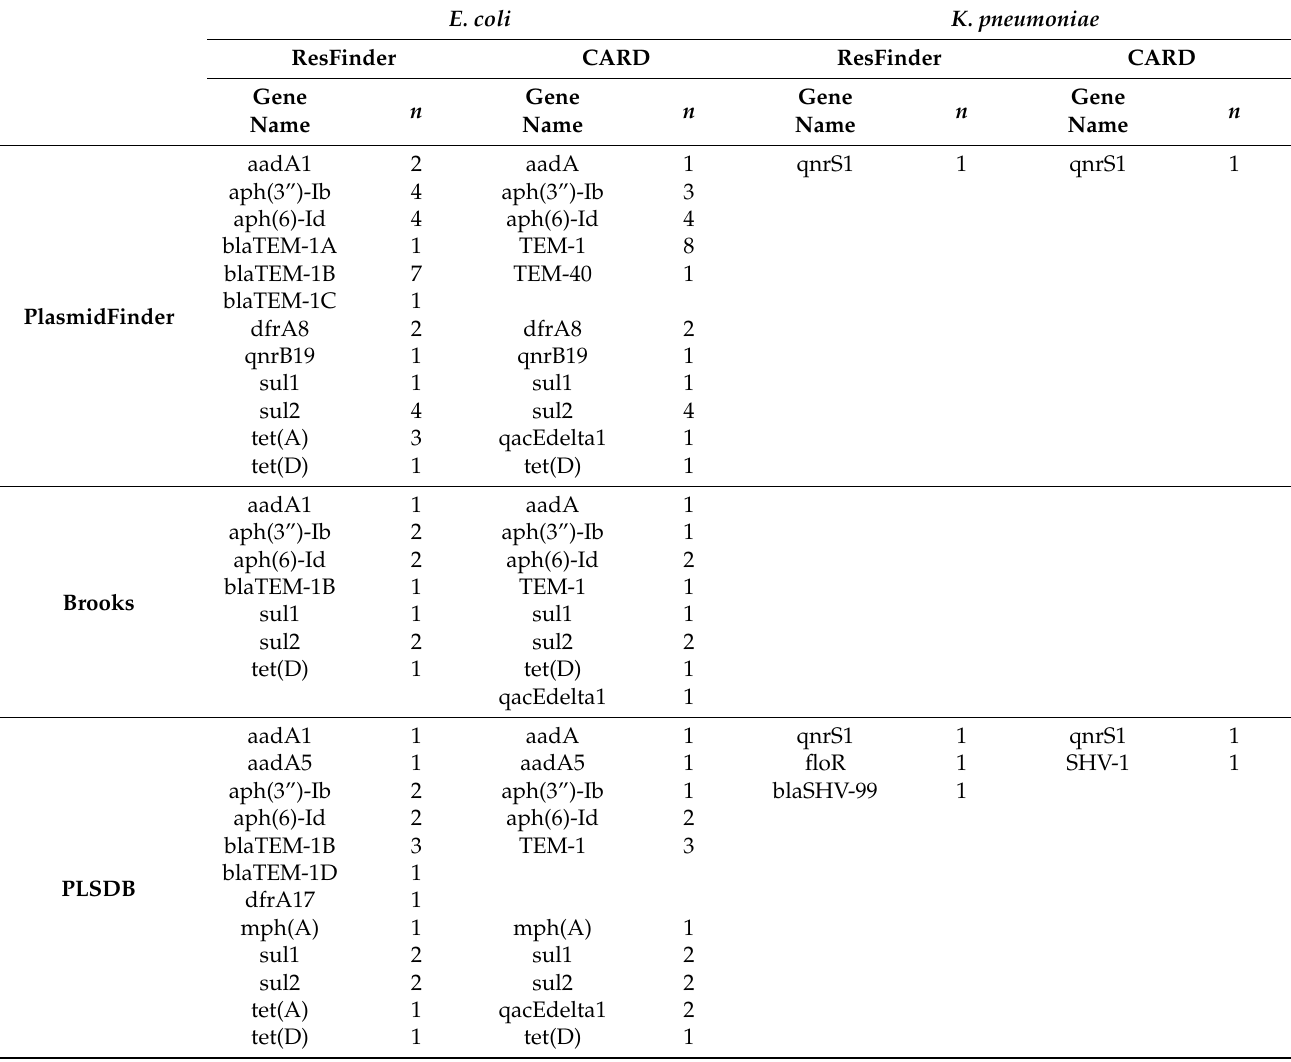
Table 6. Gene name and number of isolates with most abundant ARG Plasmid for both E. coli and K. pneumoniae isolates. E.